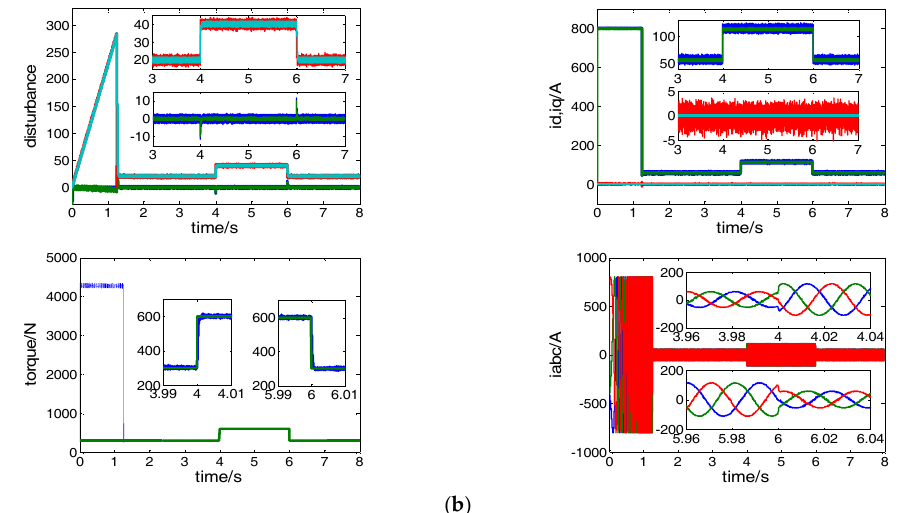
Figure 9. Simulation comparisons of the two controllers against inductance parameter perturbation ( ∆ L d = − 50% L do , ∆ L q = − 50% L qo ): ( a ) Conventional PCC and ( b ) proposed CRFTPC.